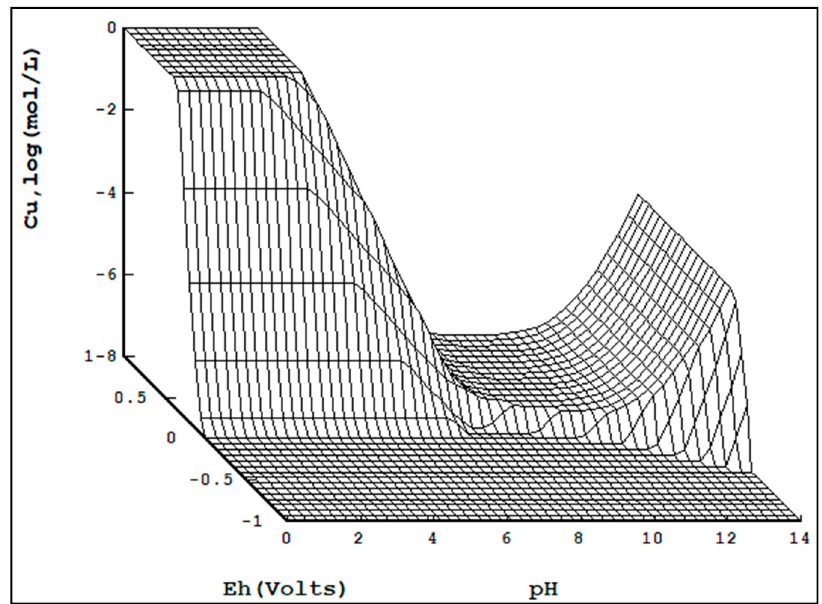
Figure 3. 3D Cu Pourbaix diagram.